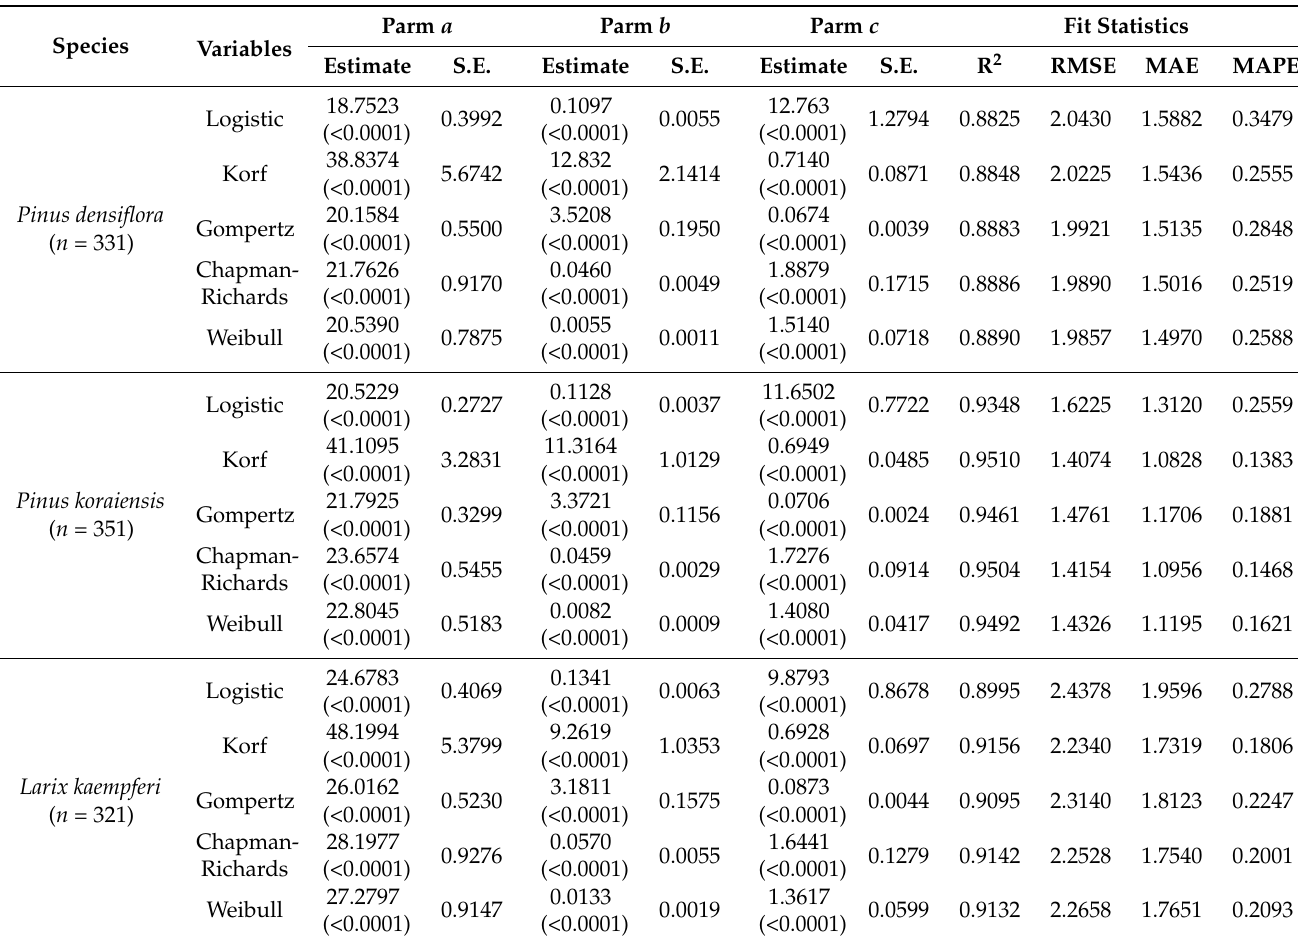
Table 4. Model parameters of height growth functions and indicators of